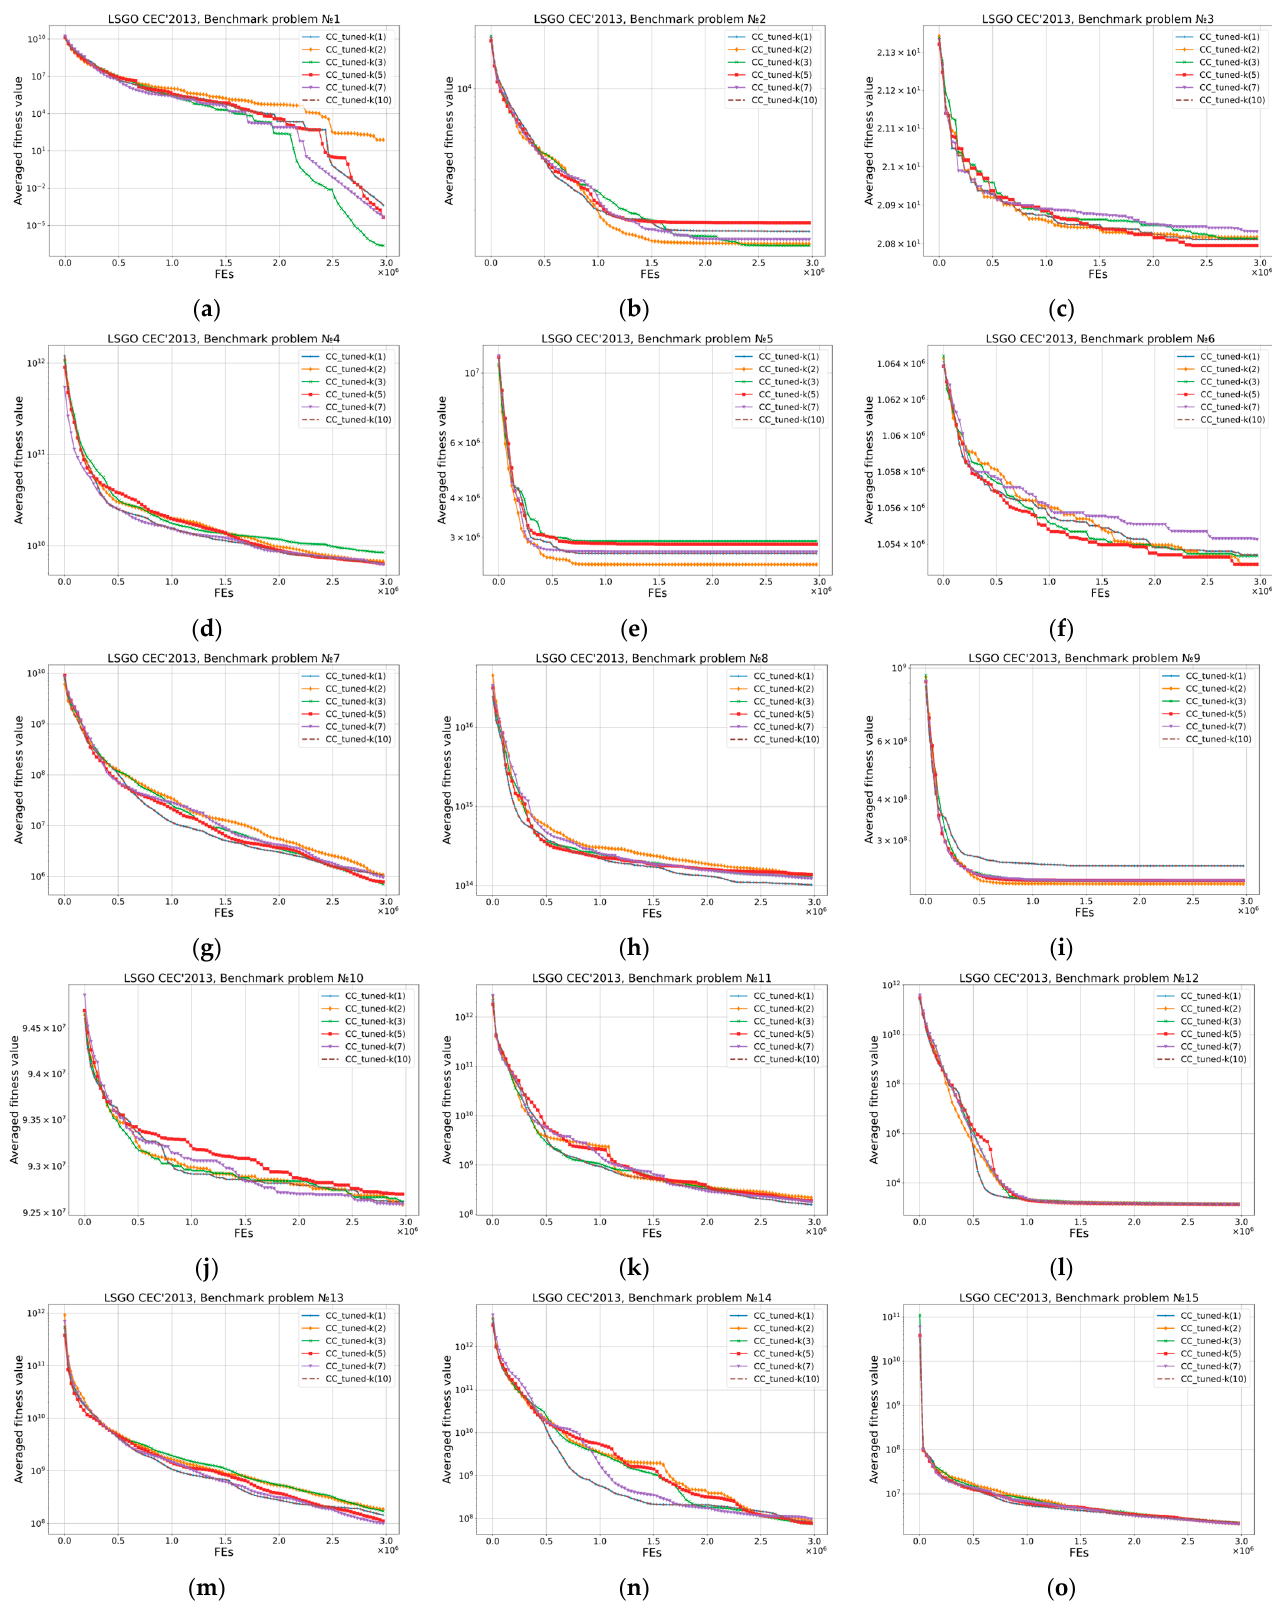
Figure 8. Convergence plots of CC-tuned-k algorithms. Benchmark problems are: ( a ) F 1 ; ( b ) F 2 ; ( c